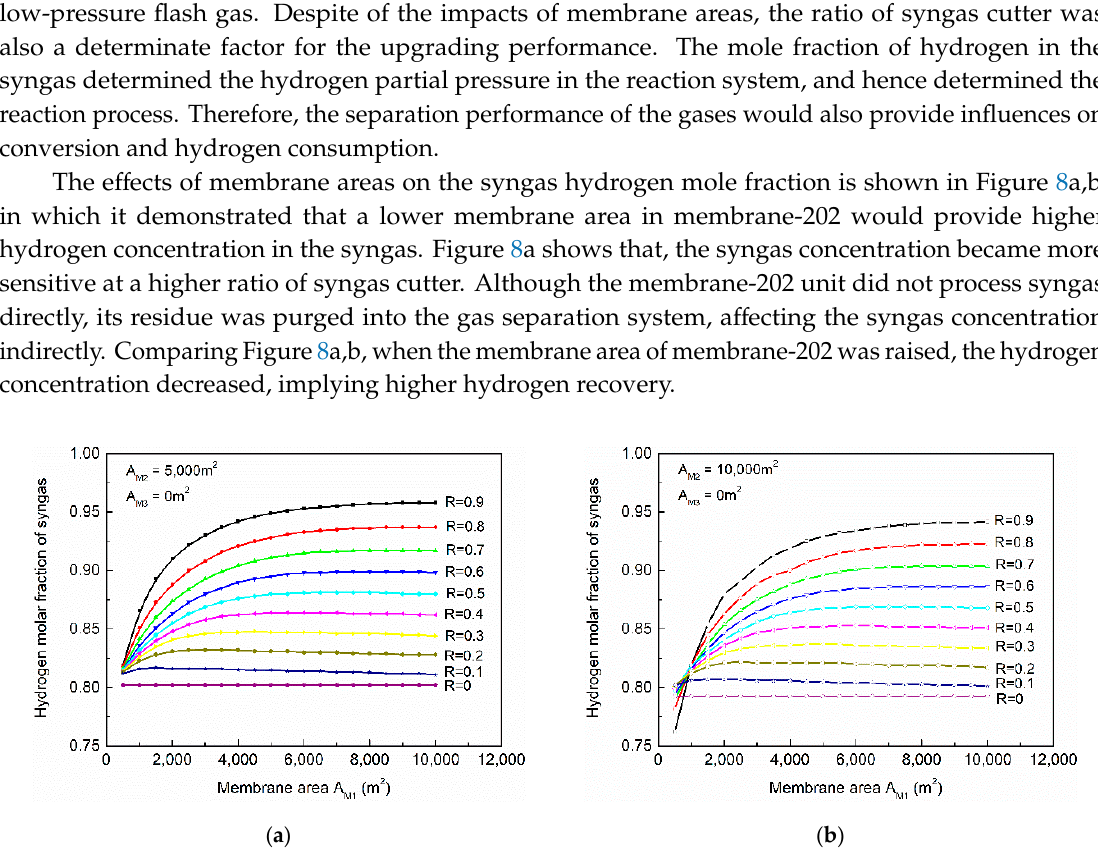
Figure 7. Impacts of operating temperature on product distribution. WGS refers to water–gas-shift reaction; K eq refers to the reaction equilibrium constant.